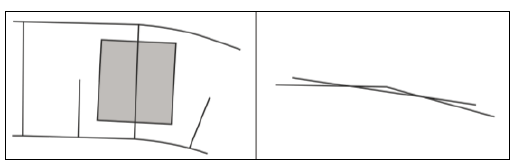
Figure 11. Terrain kink in the transition area of polder 2 to polder 3 (planar view from east)